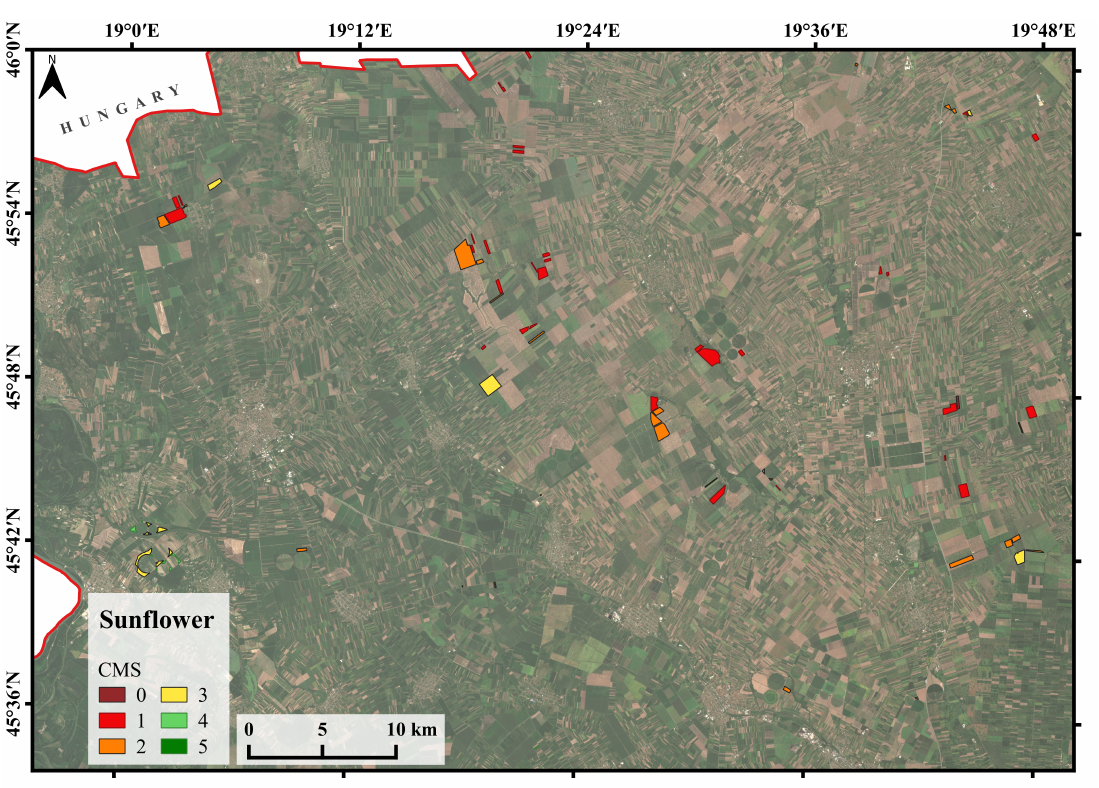
Figure 6. Map of sunflower fields with CMS classes for